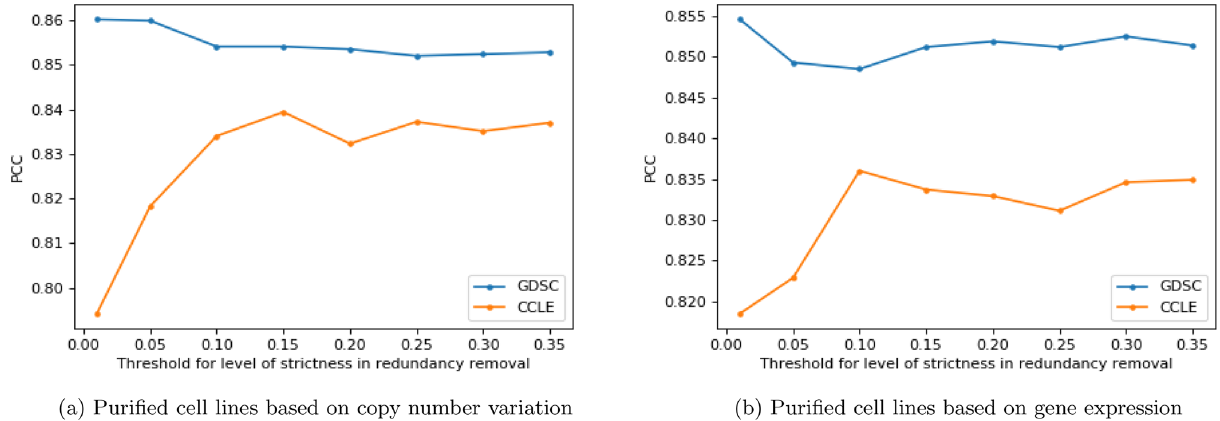
Figure 6. Performance of ADRML on purified datasets with different levels of strictness. The purified datasets were obtained after redundancy removal with certain thresholds. Each panel shows the PCC of ADRML assessed using 5-fold cross-validation on the purified